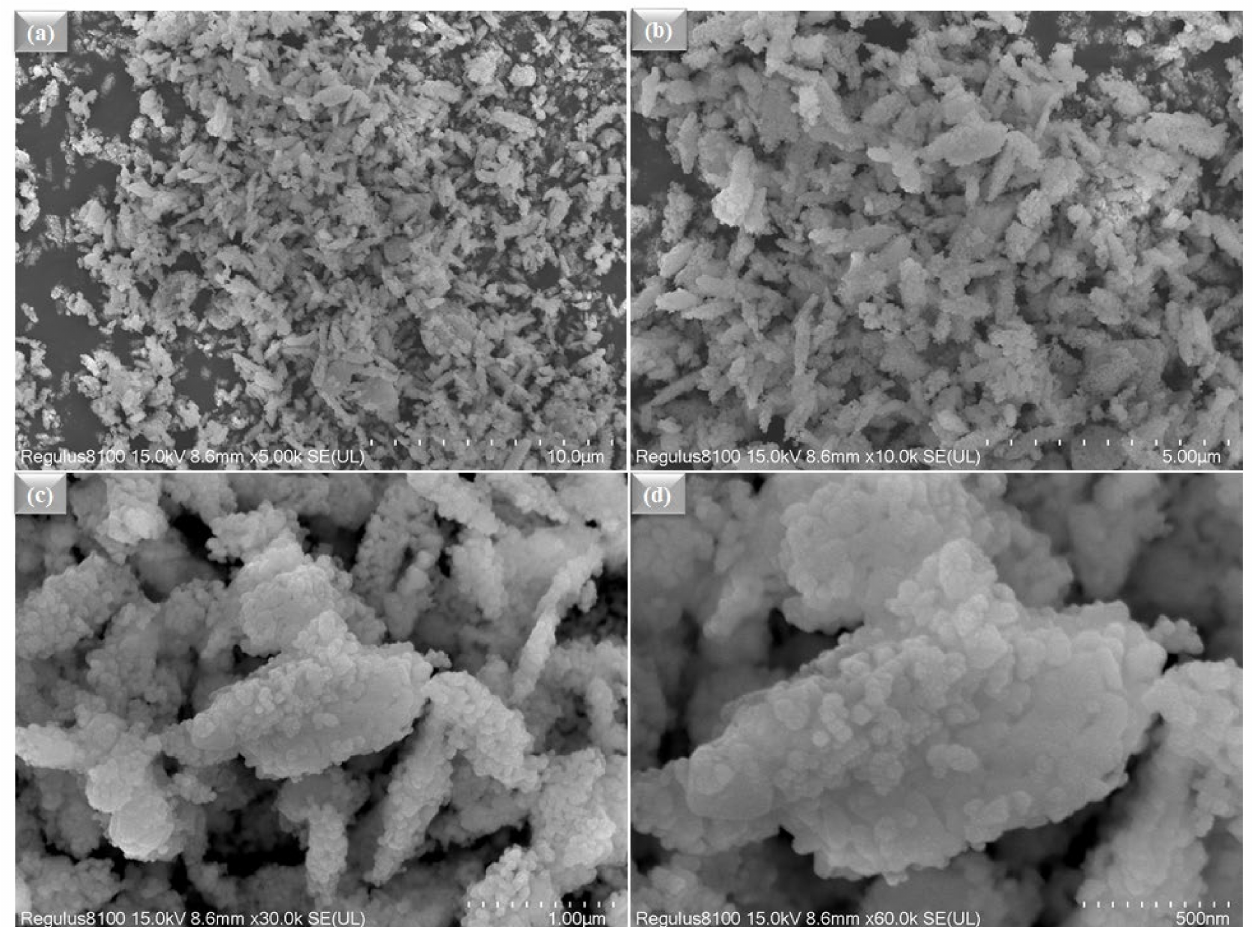
Figure 2. ( a – d ) The surface morphology studied by SEM for La 0.2 Sr 0.8 Co 0.8 Ce 0.2 O 3 − δ powder at different scales, such as 10 µ m − 500